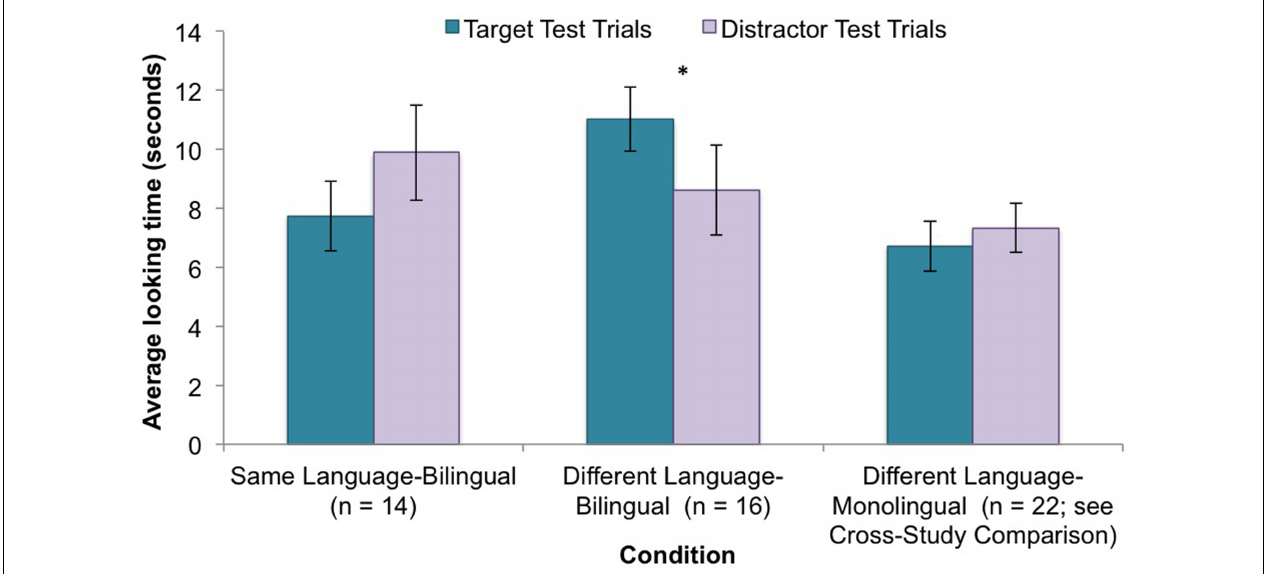
FIGURE 2 | Infants’ average looking time ( (cid:6) SE) toward each type of test trial for each condition * = p <